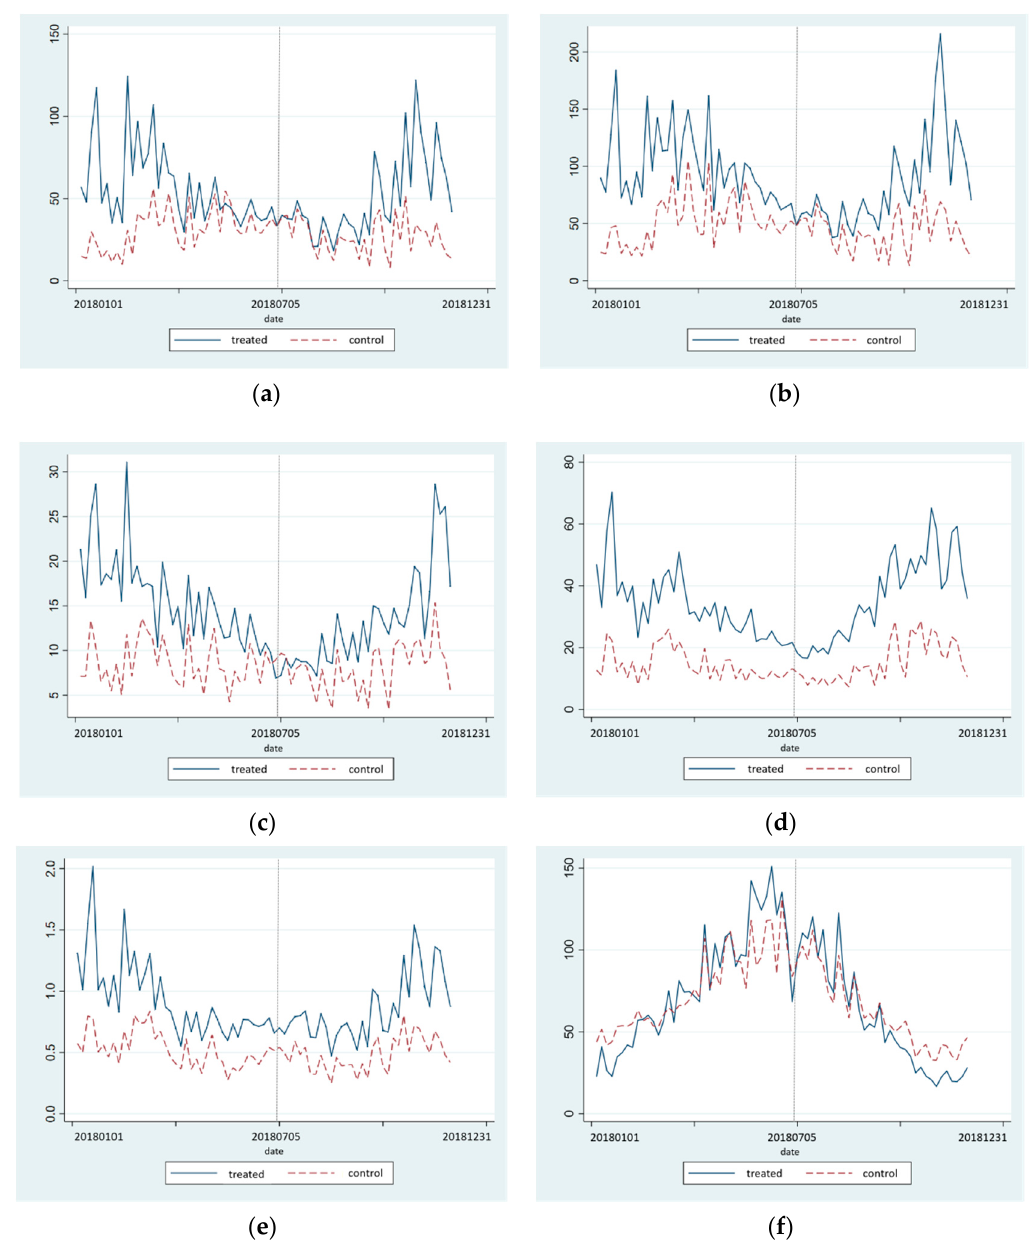
Figure 2. Parallel trend test (( a ) PM 2.5 , ( b ) PM 10 , ( c ) SO 2 , ( d ) NO 2 , ( e ) CO, ( f ) O 3 ).